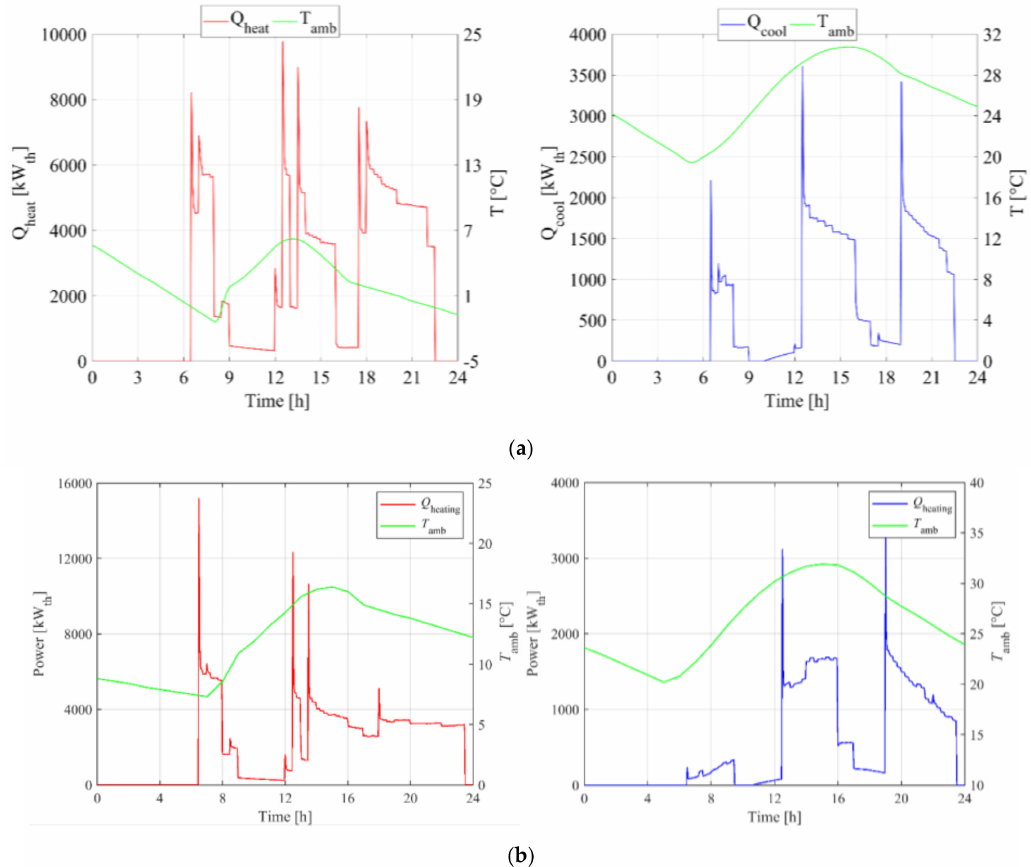
Figure 5. Thermal energy demand profile for a representative winter day (left) and a representative summer day (right) of the districts located in ( a ) Naples and ( b )